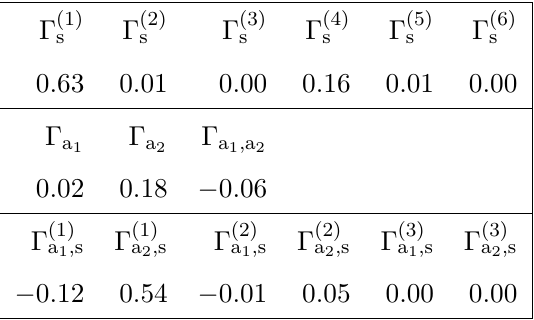
Table 4 . Decay rates needed for the evaluation of equation (4.21) and equation (4.23), all in units of 10 − 10 GeV. The ρ and ρ 0 spectral functions are evaluated with equation (3.15) and equation (3.13), respectively. The latter variant is chosen for consistency with the estimate of the ρ 0 → ππ coupling via equation (4.22), see appendix